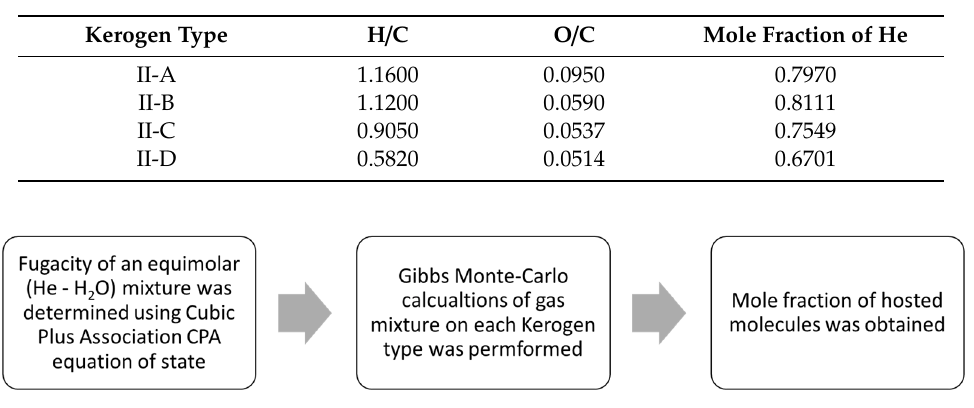
Table 6. Numeric Scale of Thermal Maturity.